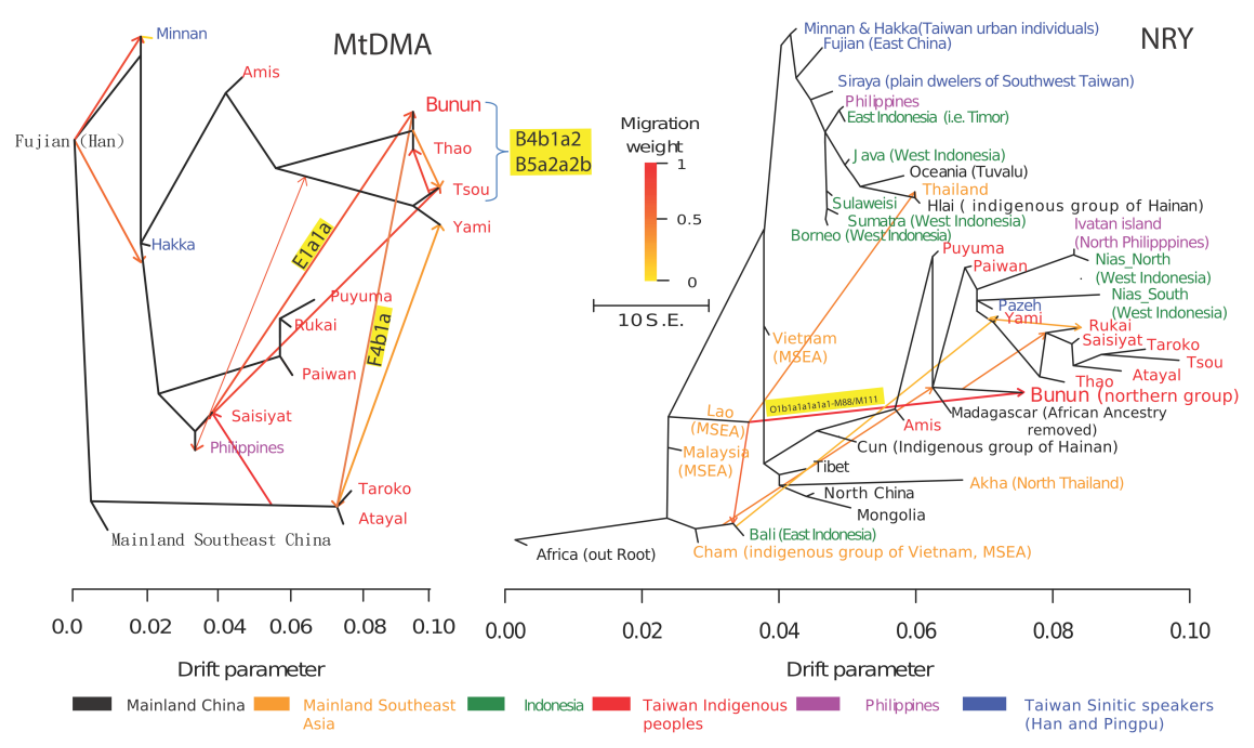
Figure 6. Inferred sources of gene flow of the Northern Bunun indigenous people. The Maximum- Likelihood tree inferred by TreeMix for Taiwan and SEA populations [78] was constructed using 15 significant gene-flow events. Shaded colored arrows represent directional gene flow across pairs of populations. For clarity, only gene flow with migration weight greater than 0.5 is shown. Left: Gene flow of mtDNA haplogroups. Note: Haplogroups shown on a yellow background (B4b1a2, F4b1a, and E1a1a) are inferences from Supplementary Table S1, and mitochondrial studies [27,80]. Right: Gene flow of NRY-STR for haplogroups O1b1a1a1a1a1-M88. Note: Haplogroups shown on a yellow background are inferences from Table 2 and Y-chromosome studies [25,68]. TreeMix detected gene flow for mtDNA from closer geographic regions compared to the Y-chromosome. This suggests that male dispersal patterns cover longer geographical distances compared to female patterns.